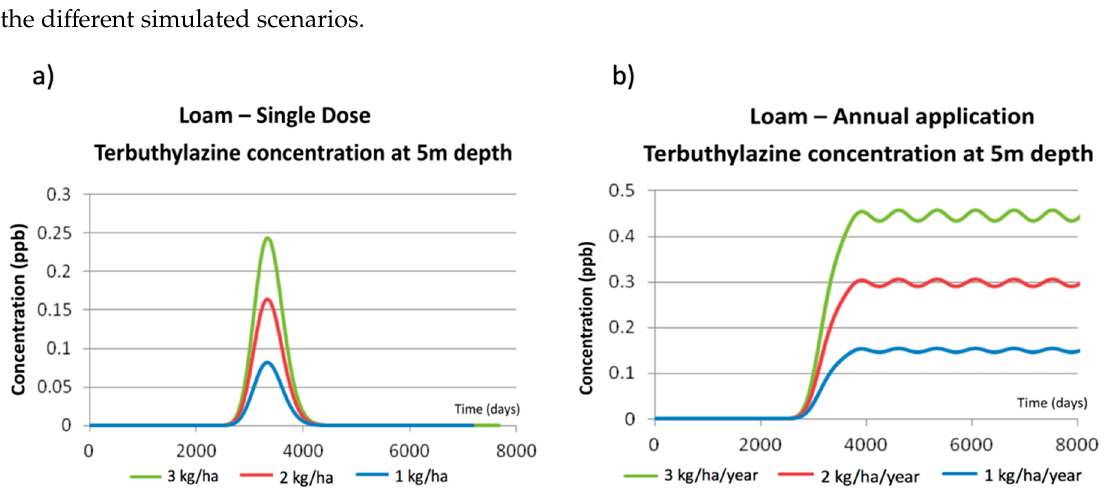
Figure 3. PESTAN terbuthylazine concentrations in loamy soil at 5 m depth. ( a ) Single dose application. ( b ) Annual application.